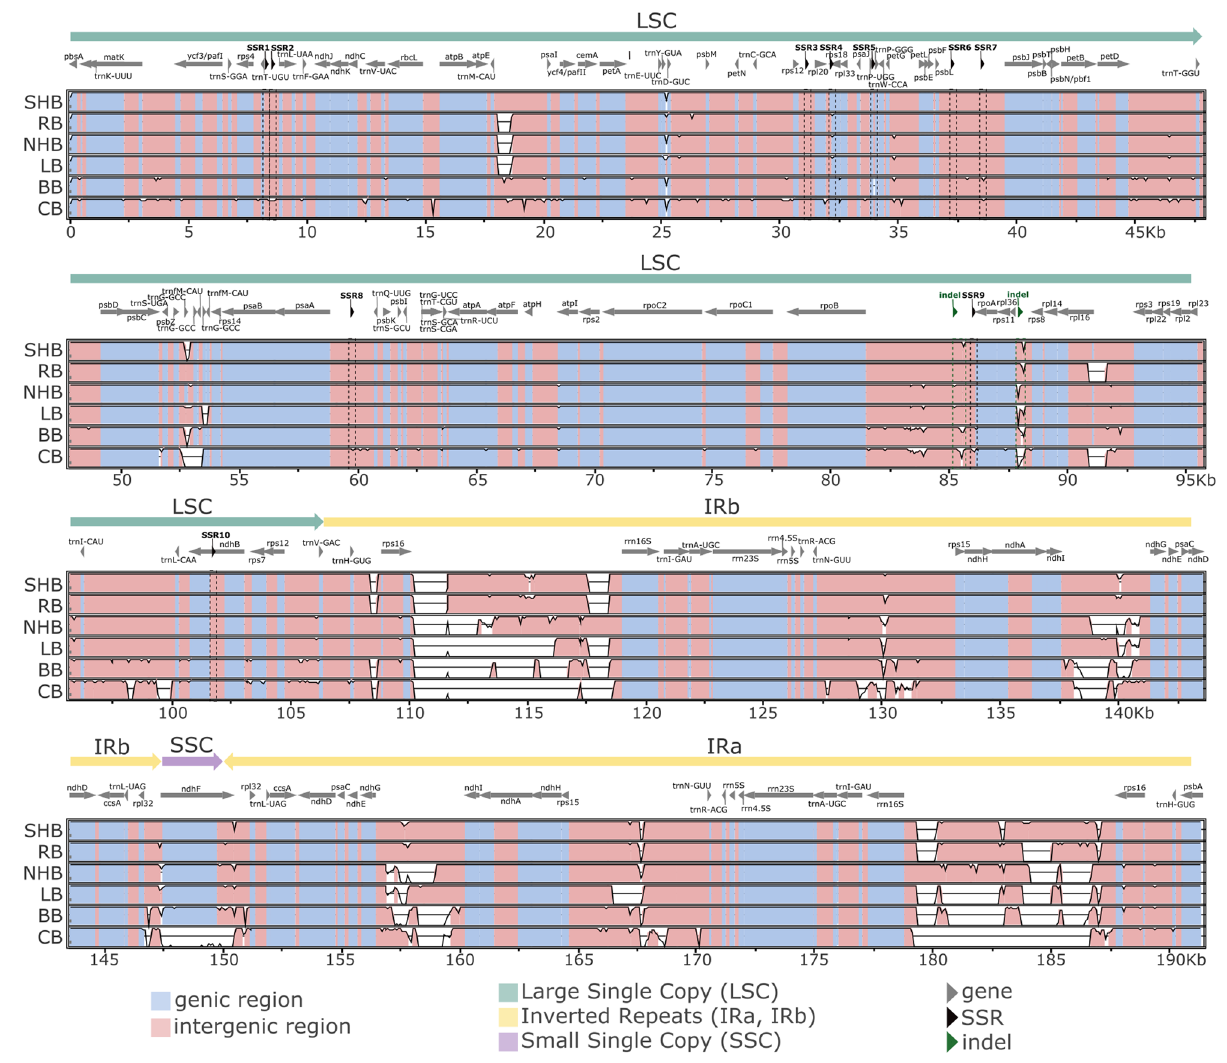
Figure 2. Multiple sequence alignment of Vaccinium chloroplast genomes performed with mVISTA. The x-axis represents the coordinates of the southern highbush blueberry chloroplast genome sequence. The y-axis represents the percentage identity ranging from 50 to 100% for each Vaccinium species. Divergent regions due to low sequence similarity or the presence of insertions/deletions are shown in white. Polymorphic simple sequence repeat (SSR) and indel regions are highlighted with dashed lines. Abbreviations correspond to the species common names as follows: SHB (southern highbush blueberry), RB (rabbiteye blueberry), NHB (northern highbush blueberry), LB (lowbush blueberry), BB (bilberry), and CB